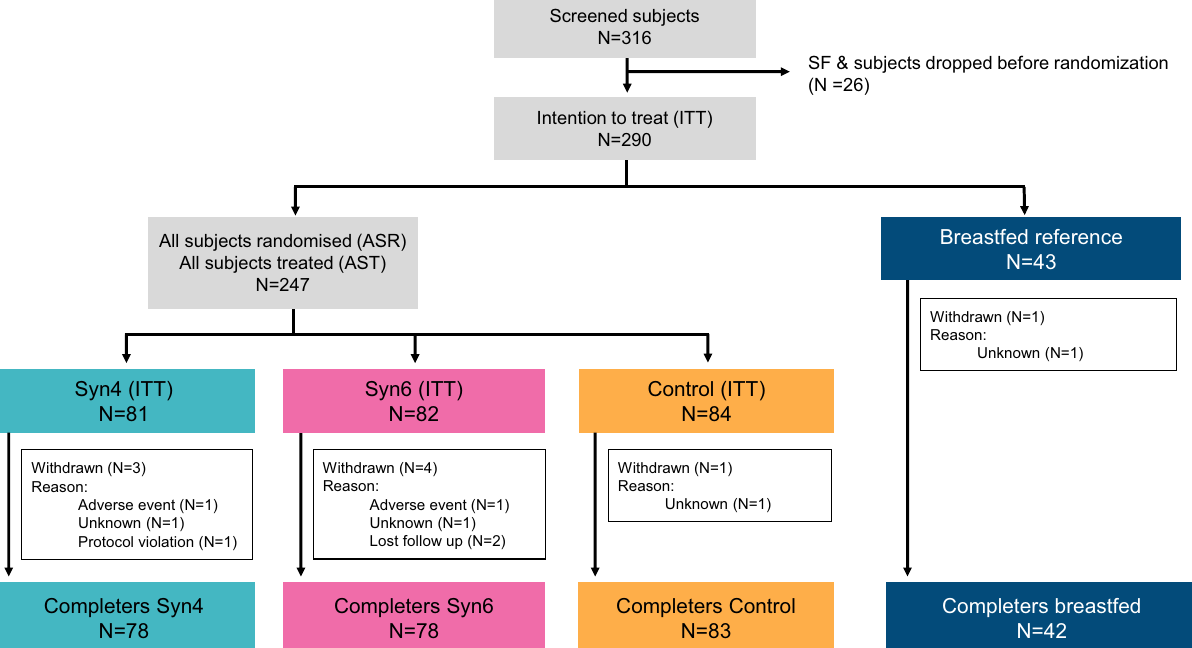
Figure 2. Study population composition. Screen Failure (SF) is defined as “potential subject did not meet one or more inclusion criteria. Intention to treat (ITT) includes every subject randomized to treatment